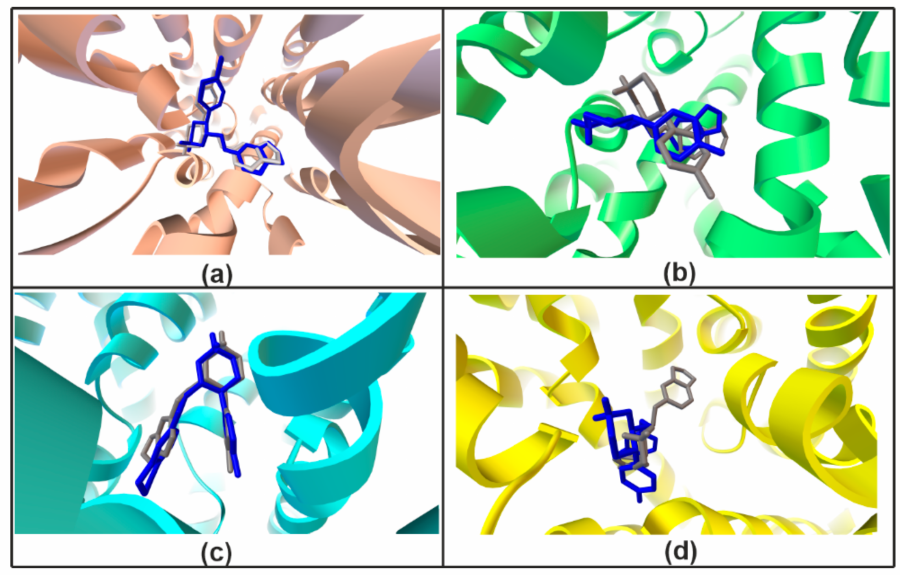
Figure 6. Validation redocking experiment. Docking results of the hSERT ( a ), hNET ( b ), hDAT/cocaine ( c ), hGAT1 ( d ) obtained using AutoDock (gray) and Vina (blue).